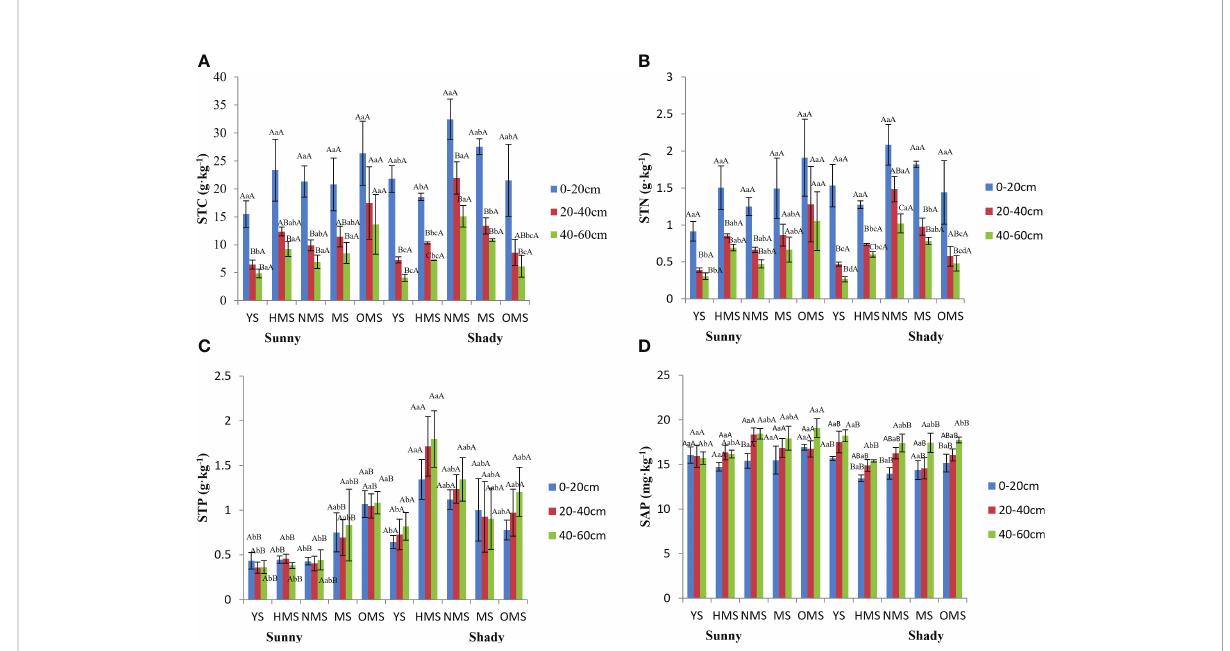
FIGURE 4 STC of soil (A) , STN of soil (B) , STP of soil (C) , and SAP of soil (D) . Different capital letters indicate signi fi cant differences in soil layers and different lowercase letters indicate signi fi cant differences forest ages, and additional different capital letters indicate signi fi cant differences in site conditions ( p< 0.05). YS, Young stage; HMS, Half-mature stage; NMS, Near-mature stage; MS, Mature stage, OMS, Over-mature stage. Sunny: Sunny slope, Shady: Shady